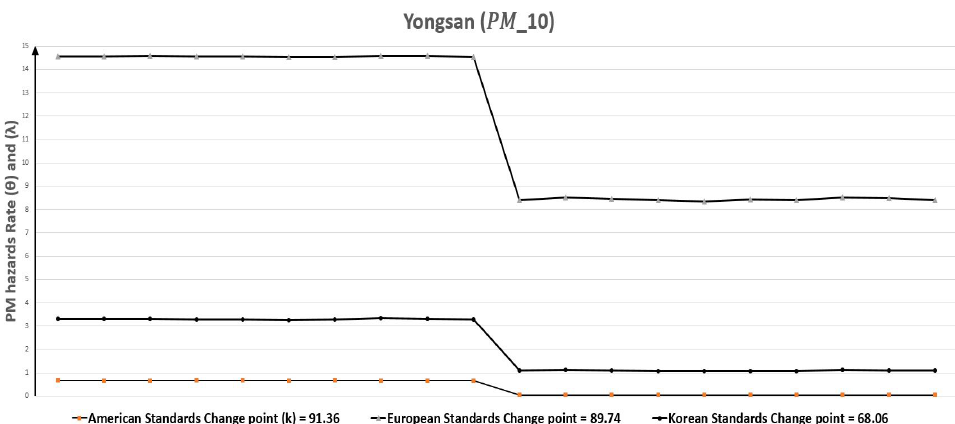
Figure 25. Yongsan (Seoul, South Korea) monthly polluted days before and after the change point due to PM 10